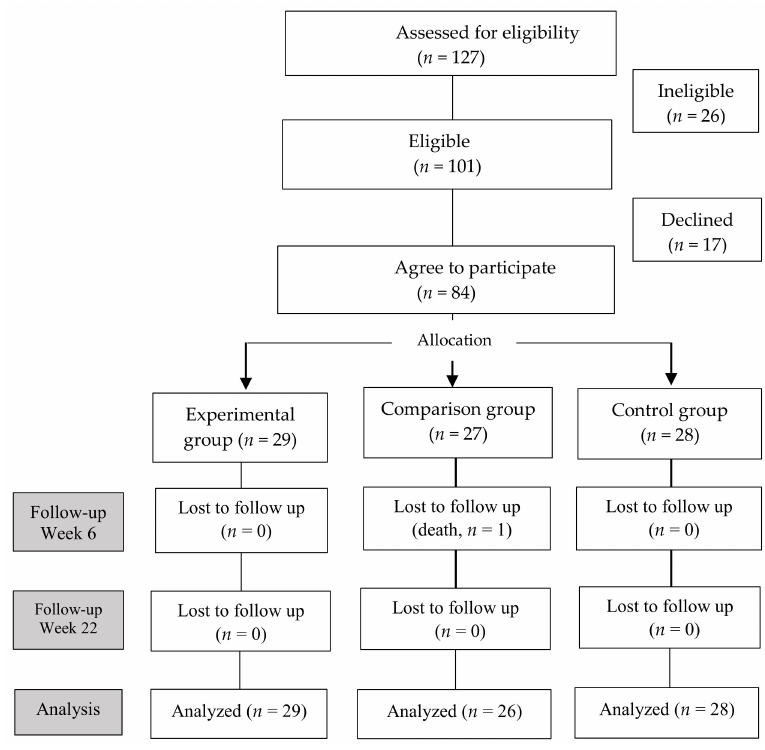
Figure 1. Flowchart of